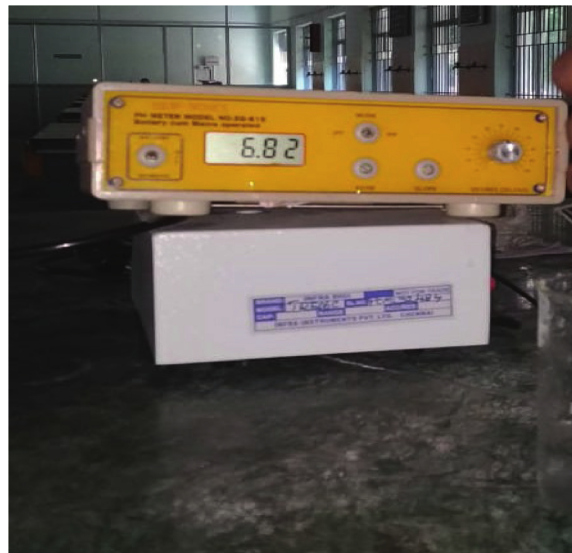
Figure 12: pH value after first filtration.